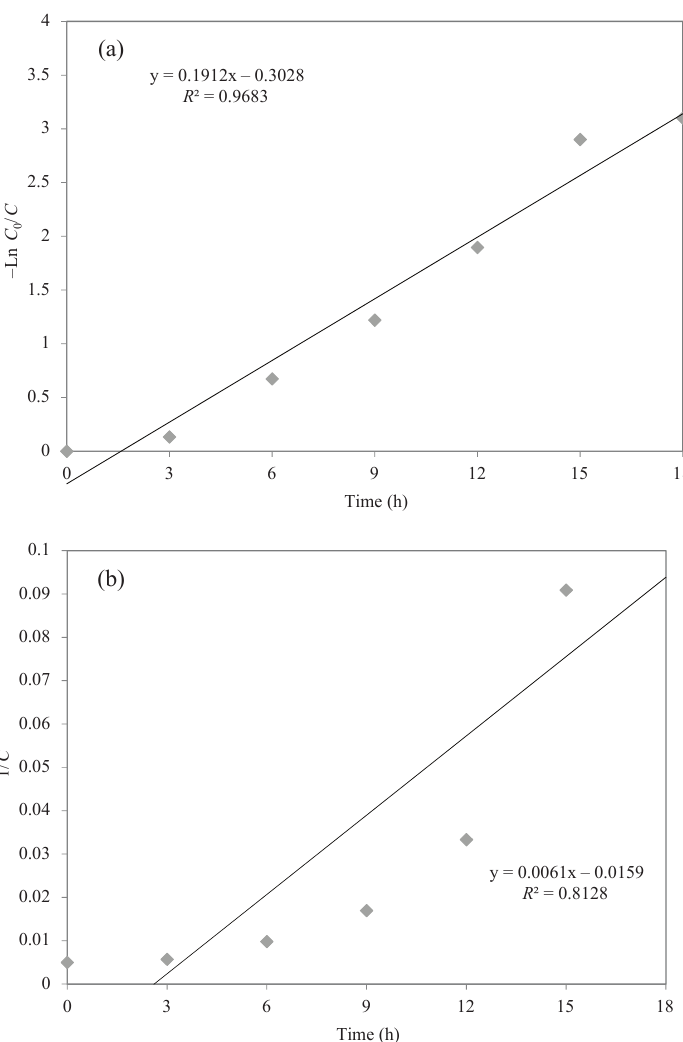
y = 0.0061x – 0.0159 R ² =